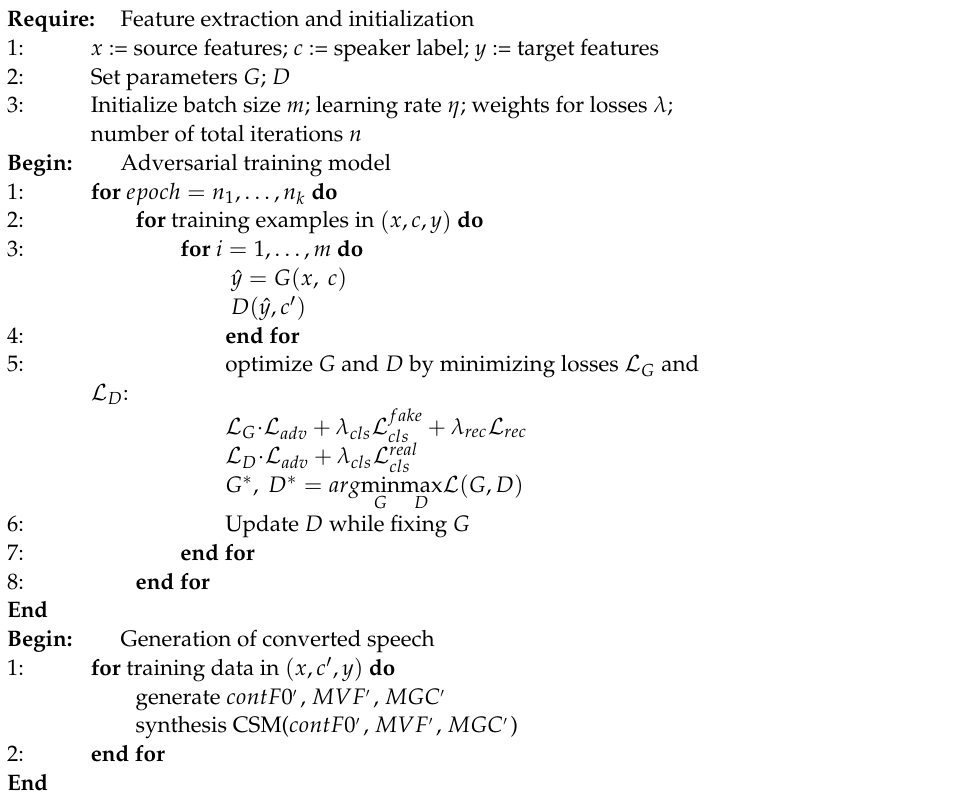
Algorithm 1 Acoustic modeling for voice